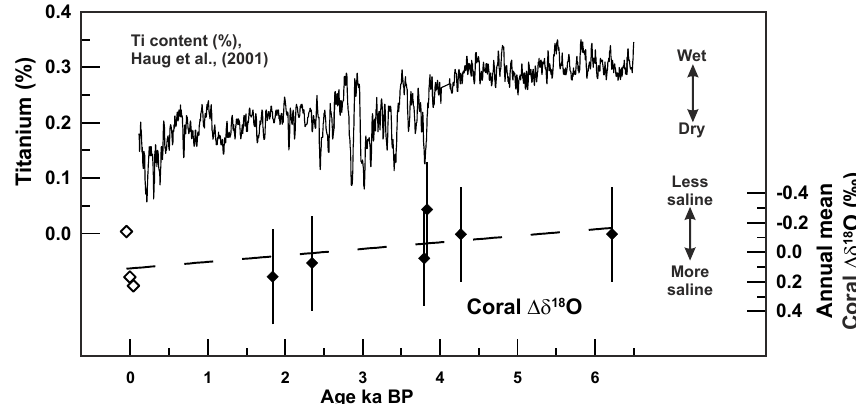
Fig. 3. Comparison between mean coral 1δ 18 O and Cariaco Basin Ti record (Haug et al., 2001). Coral 1δ 18 O has been calculated for individual records using established procedures (Cahyarini et al., 2008; Corr`ege, 2006; Gagan et al., 1998). Error bars are the combined error (root of the sum of the squares) of the standard deviation (2 σ ) from mean coral 1δ 18 O of three modern Diploria strigosa and the standard error (2SE) of the mean coral 1δ 18 O value for individual corals, following established procedure (Abram et al., 2009) but applied to reconstructed coral 1δ 18 O. Note that coral 1δ 18 O records indicate a trend toward more saline conditions during the mid- to late Holocene that might be linked to more precipitation at 6ka.